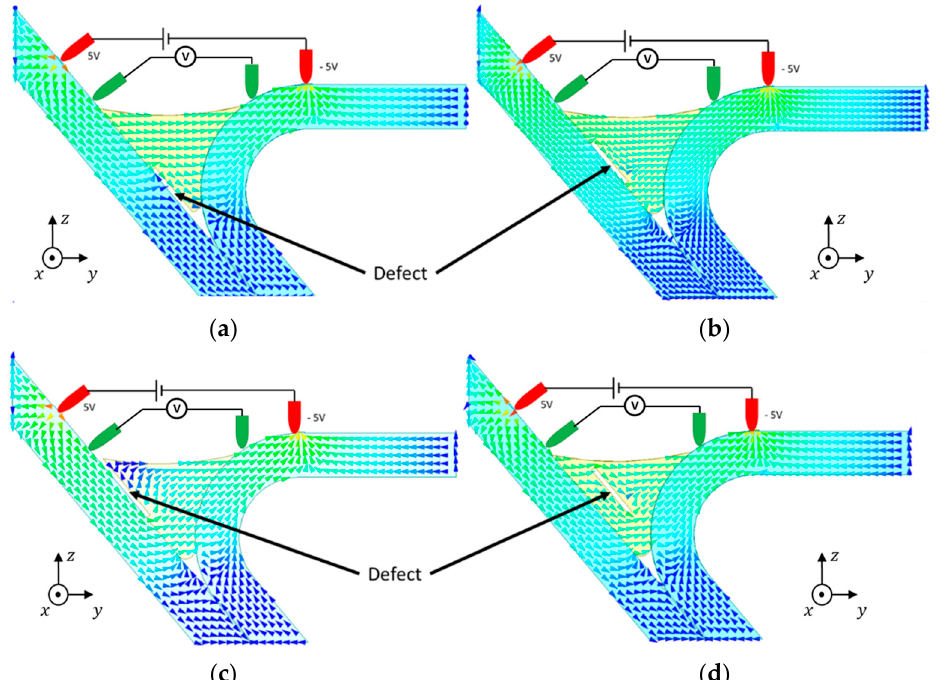
Figure 4. Current density vector field behavior in a weld with different defect locations.